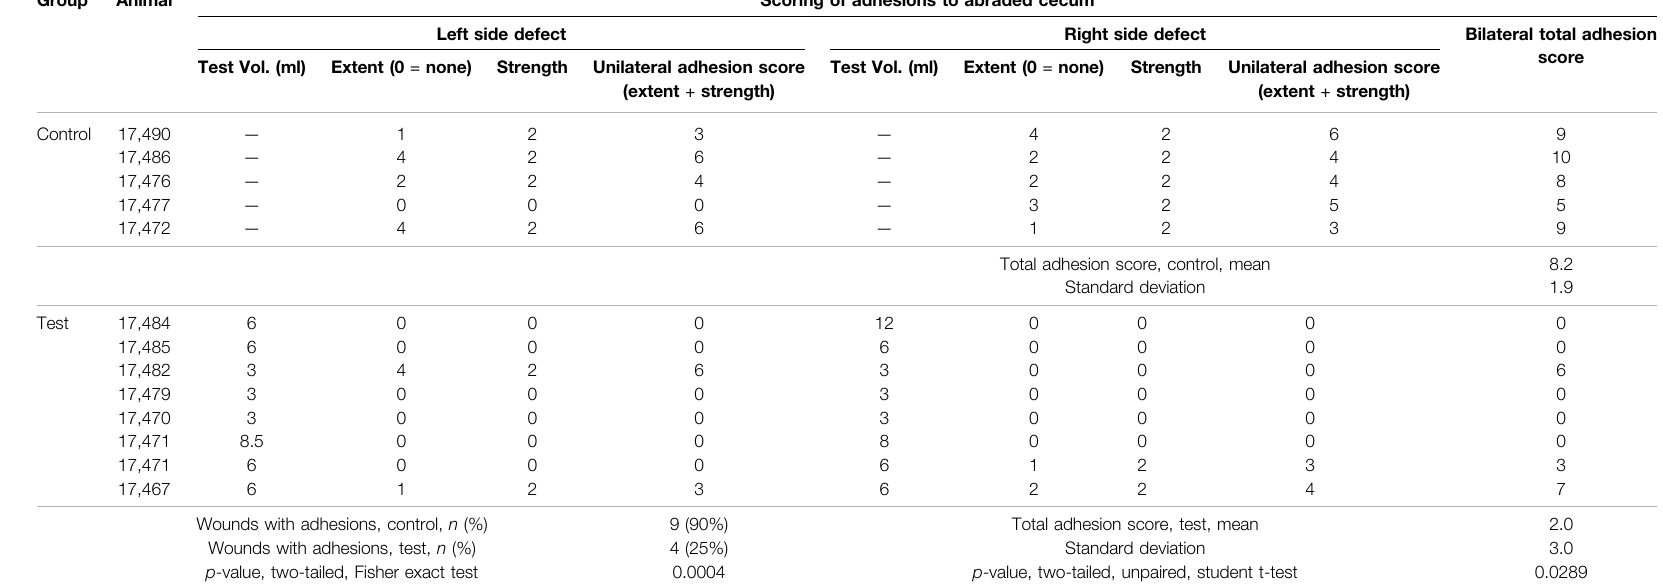
TABLE 3 | Adhesion scores in abraded cecum, and PuraStat volumes administered. Group Animal Scoring of adhesions to abraded cecum Left side defect Right side defect Test Vol. (ml)